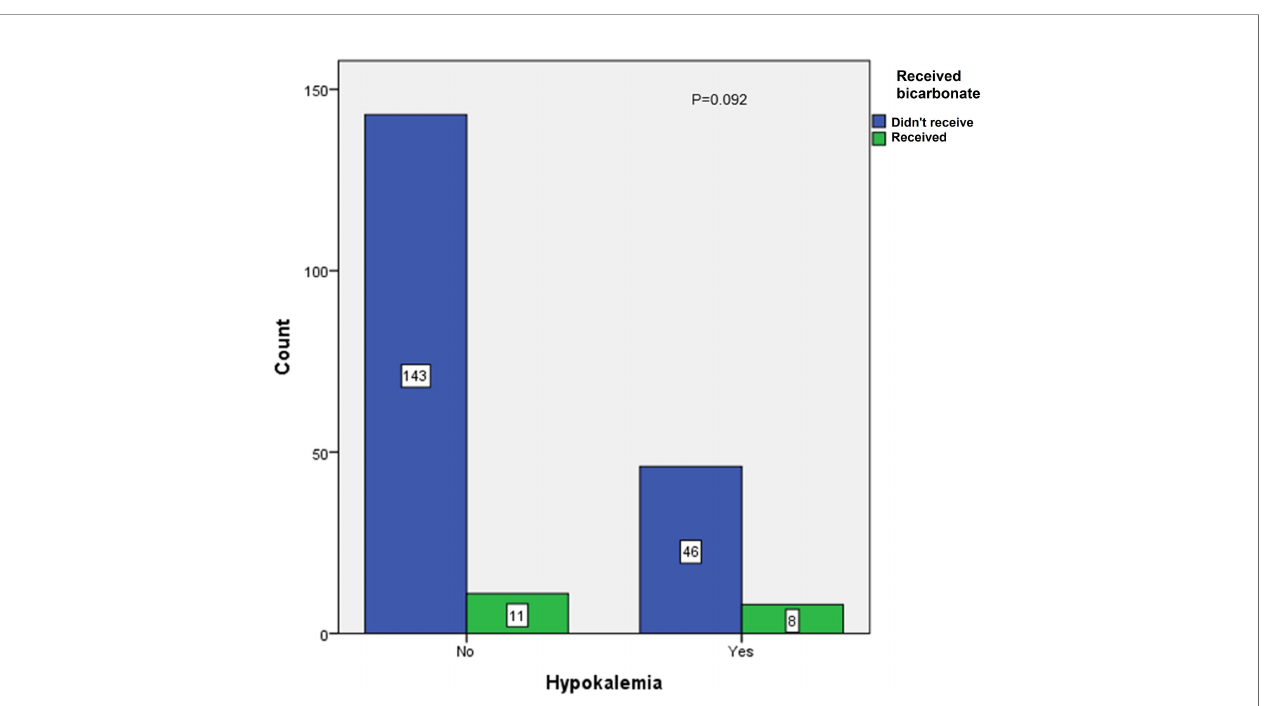
FIGURE 2 | Association between hypokalemia and intake of sodium bicarbonate in the second COVID-19 wave.